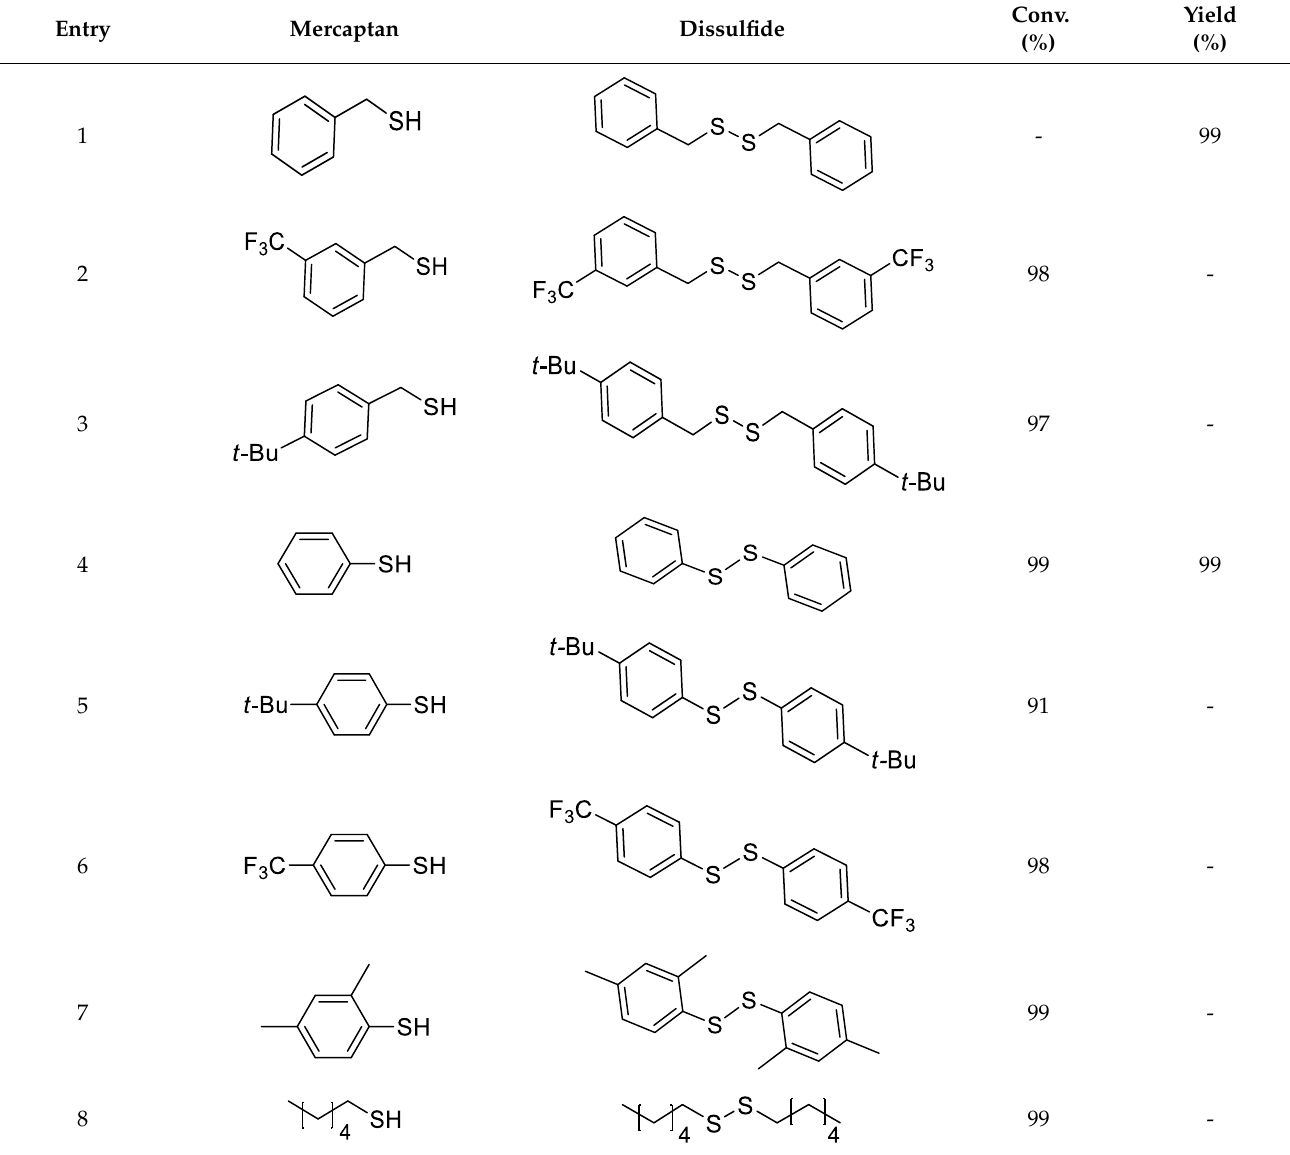
Table 2. Examples and scope of aerobic oxidation of thiols using Fe(II)Pc as catalyst [64] . Entry Mercaptan